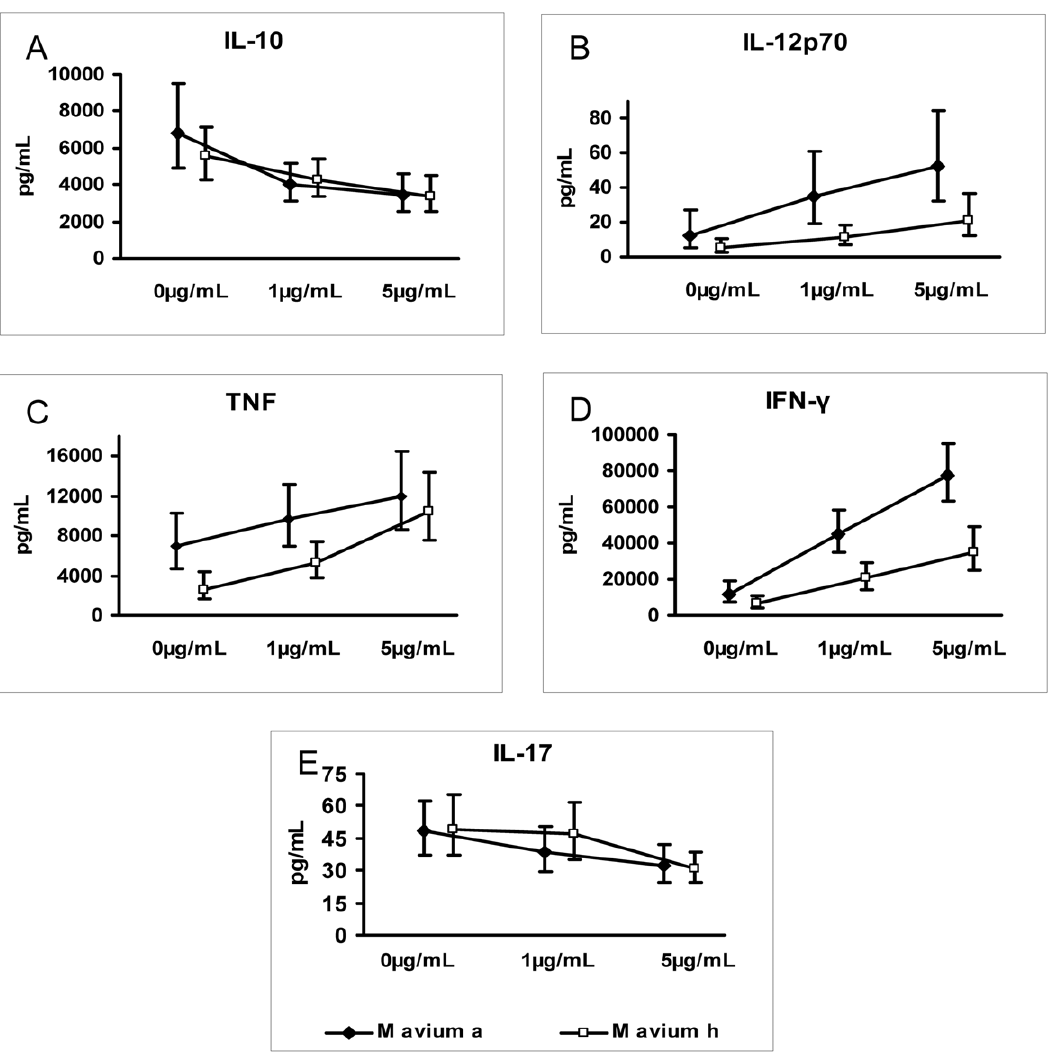
Figure 2. Cytokine levels when blocking IL-10: (A) IL-10, (B) IL-12p70, (C) TNF, (D) IFN- c , (E) IL-17. Cytokine levels in pg/mL after stimulation with 5 6 10 6 inactivated bacteria/mL of PBMCs from four healthy blood donors that had been pre-incubated with anti-IL-10 antibodies at 0, 1 and 5 m g/mL respectively are shown. M avium a= Mycobacterium avium avium ; M avium h= Mycobacterium avium homunissuis .